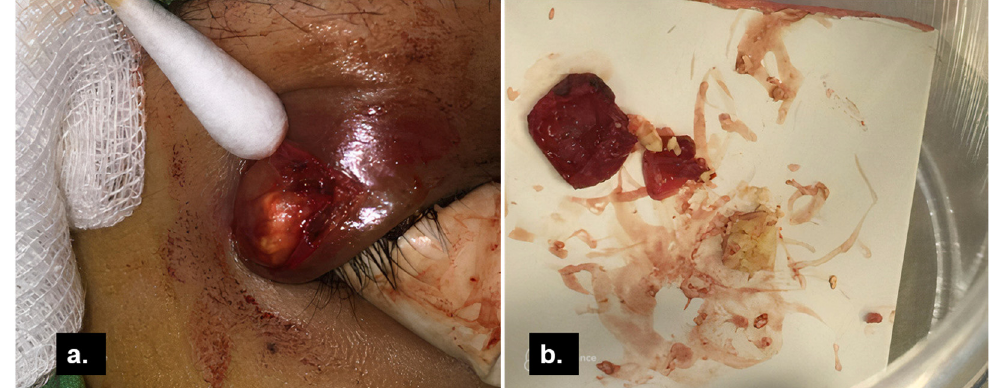
Figure 3. Intraoperative photograph of the cystic lesion. ( a ) After careful dissection of skin crease, orbicularis oculi muscle, and septum, the lesion with fluid and solid components was exposed. ( b ) Although ruptured during dissection, the capsule was removed in whole, and yellowish, caseous contents were expressed from the excised cyst.